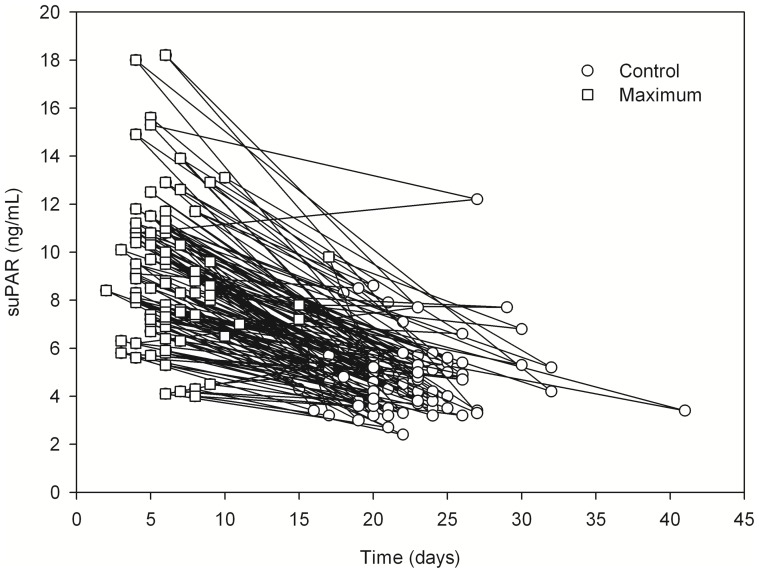
Line chart showing soluble urokinase-type plasminogen activator receptor (suPAR) maximum (median 8.7 ng/ml, range 4.0–18.2 ng/ml) and convalesce phase concentrations (median 4.7 ng/ml, range 2.4–12.2 ng/ml) in relation to the onset of fever (day 0) in 97 patients with Puumala hantavirus infection (P-value for the difference <0.001).Short title: Line chart showing suPAR maximum and convalescence concentrations in relation to the onset of fever.